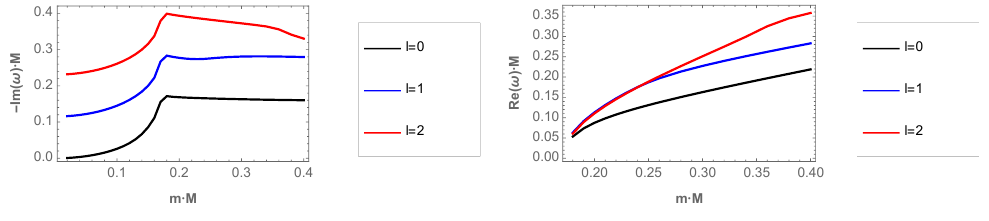
Figure 4 . The behaviour of the dominant dS modes ( n dS = 0), (cid:0) Im ( ! ) M (left pannel) and Re ( ! ) M (right pannel) as a function of mM for di(cid:11)erent values of the parameter ‘ = 0 ; 1 ; 2, with M 2 (cid:3) = 0 :